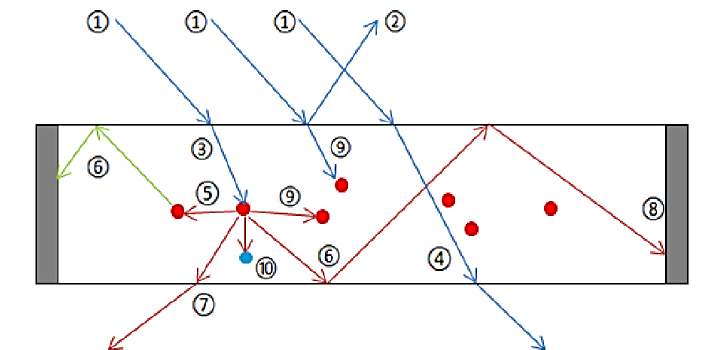
Figure 26. The luminescent solar concentrator. Red dots: dye molecule; blue dot: host absorption; 1: incident light; 2: reflected light; 3: light absorbed by a fluorophore module; 4: non-absorption loss; 5: re-absorption; 5: TIR light; 6: escape-cone loss; 7: solar cell; 8: non-radiative decay; 9: